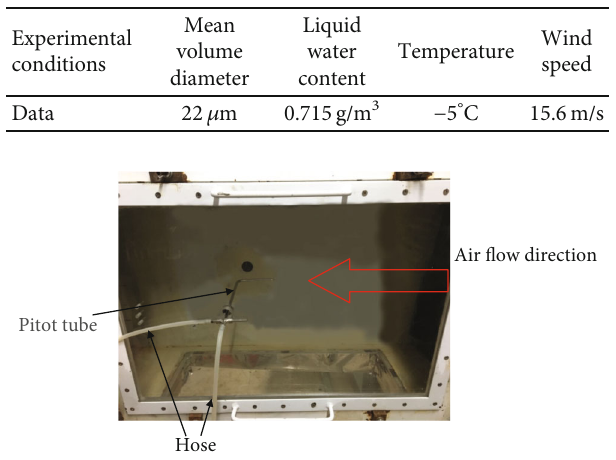
Figure 3: Schematic of the pitot tube installation in the test section.